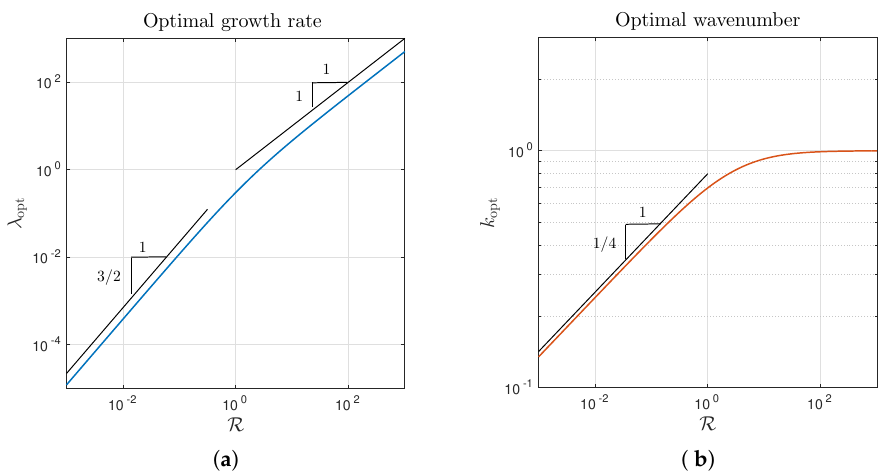
Figure 3. ( a ) Optimal growth rate λ opt and ( b ) optimal wavenumber k opt as functions of R ≡ Ra −